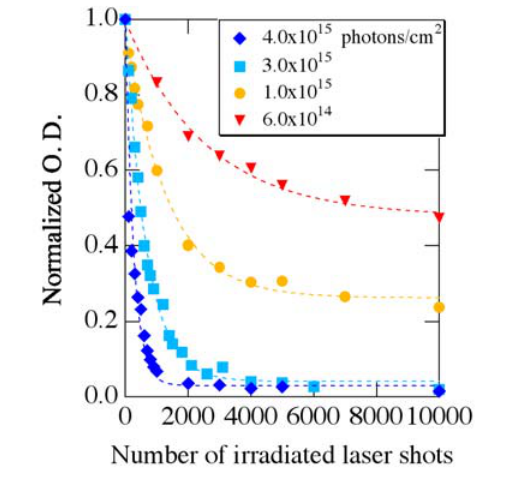
Figure 9. Photobleaching of the normalized absorbance at 470 nm as a function of number of the irradiated excitation laser shots with different photon